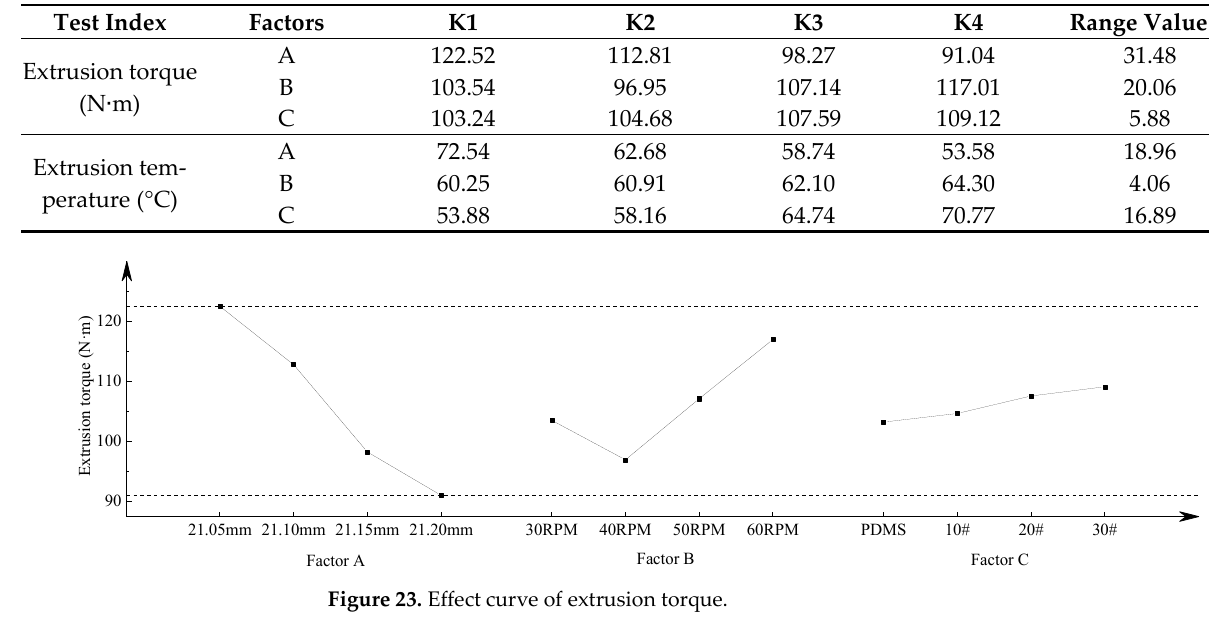
Figure 23. Effect curve of extrusion torque.